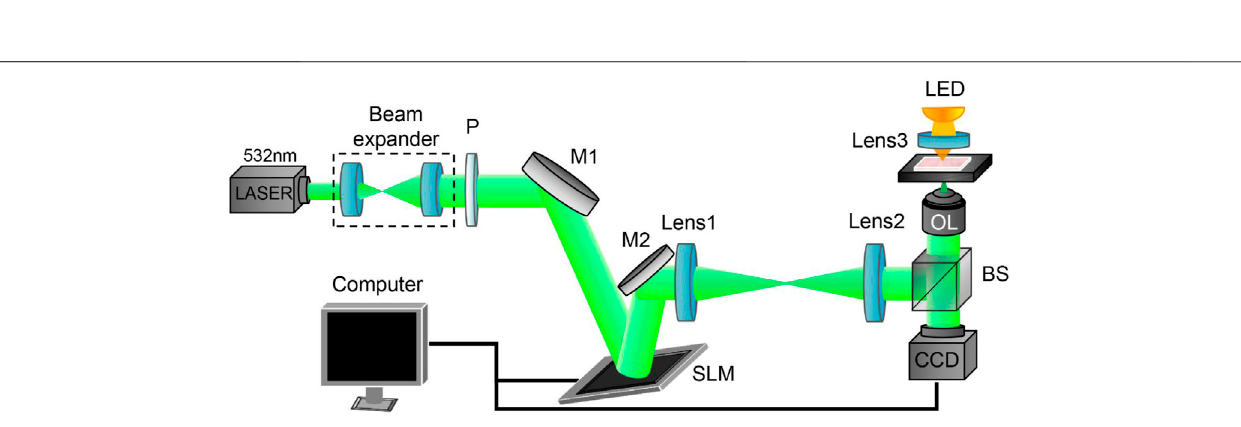
FIGURE 6 | Schematic of the experimental con fi guration. P: polarizer; BS: beam splitter; M: mirror; SLM: spatial light modulator; OL: objective lens.